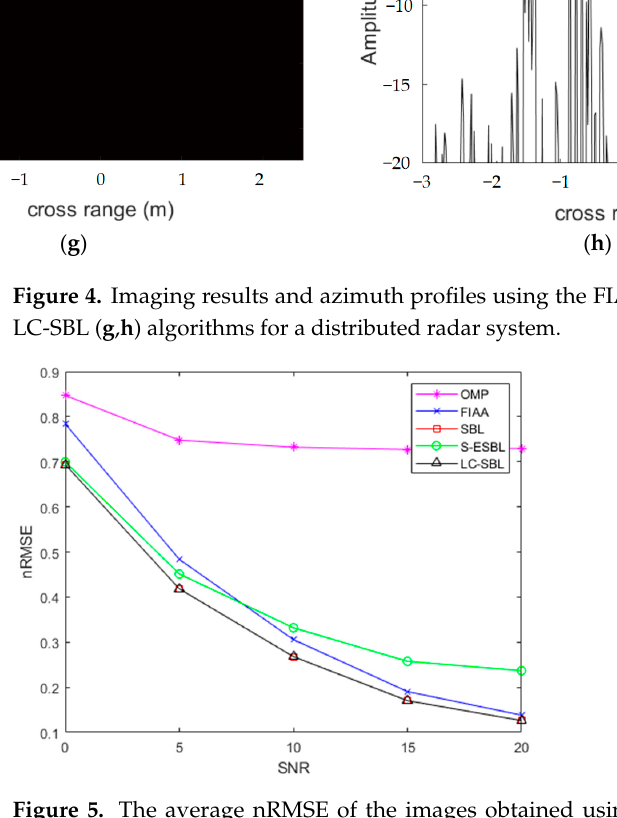
Figure 4. Imaging results and azimuth profiles using the FIAA ( a , b ), OMP ( c , d ), S-ESBL ( e , f ) and LC-SBL ( g , h ) algorithms for a distributed radar system.